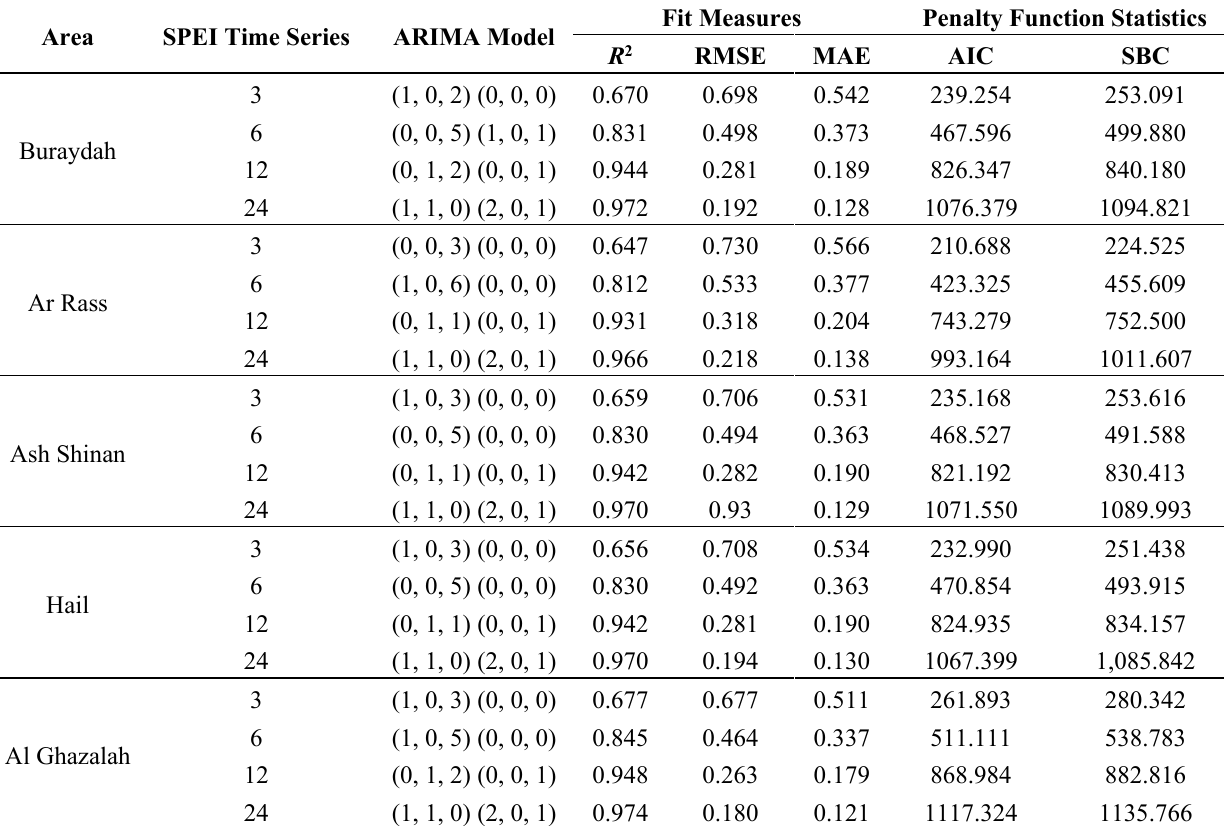
Table 3. Autoregressive integrated moving average (ARIMA) models of Standardized Precipitation Evapotranspiration Index for various study areas with forecasting fit measures and penalty function statistics for each estimated model of observed and predicted data.